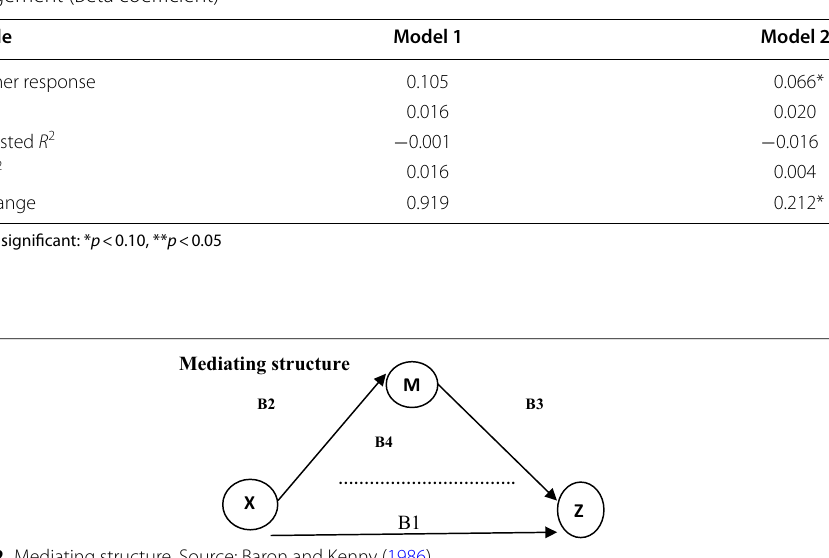
Table 10 Multiple regressions: mediating effect of operations management and financial management (Beta coefficient)